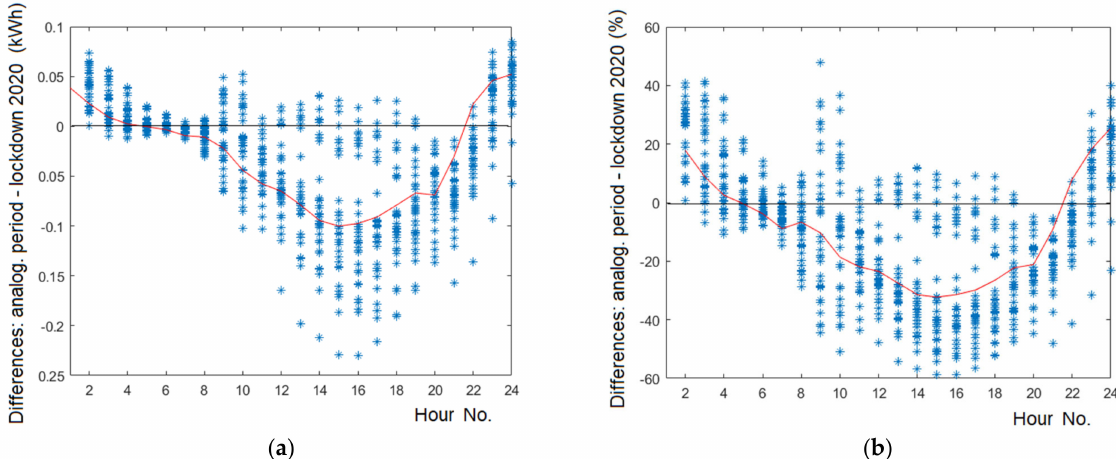
Figure 16. Differences between the average active energy consumption of the residential users in each of the 815 hours analysed, covering the same period in 2018 and the lockdown 2020 in terms of absolute ( a ) and percentage differences, relative to the average of the lockdown ( b ), ranked by the hour of the day (one point represents one of the 815 h analysed). The continuous red line represents the average of the